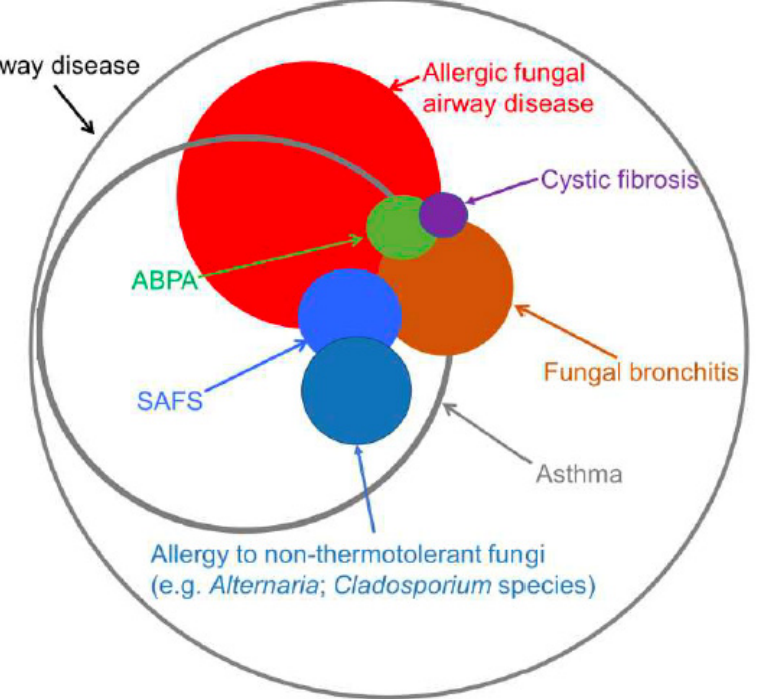
Figure 1. Concept of an overlapping spectrum of allergic fungal airway diseases. Adapted from reference